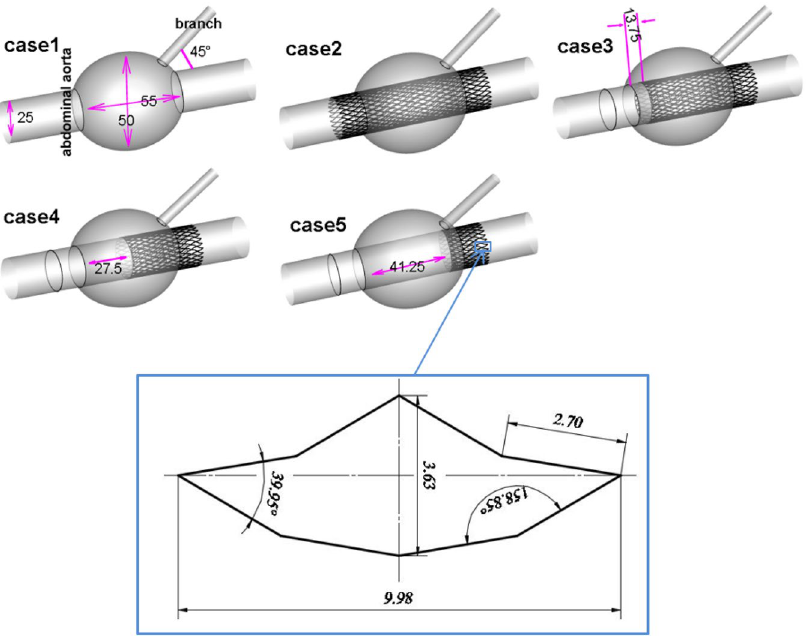
Figure 1. Models. Case1: aneurysm without stent. Case 2: aneurysm with two multilayer stents. Case 3, case 4, and case 5 were aneurysms with a combination of SG and MS, and the coverage rates of SG were 25%, 50%, and 75% respectively. The configuration of the stent element is shown in the box; it was 0.2 mm thick and had double layers (Sinus-XL stent, Optimed, Germany, mesh porosity =